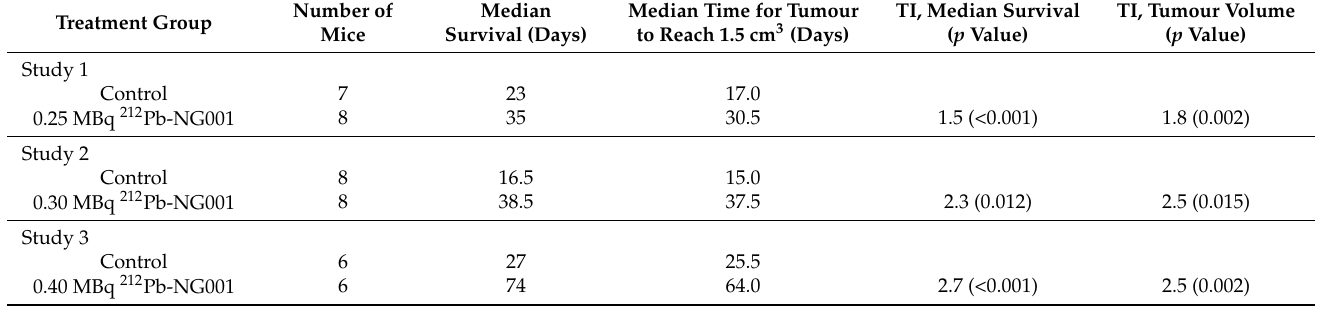
Table 2. The therapeutic effect of 212 Pb-NG001 in athymic nude mice with C4-2 xenografts. The therapeutic index (TI) was calculated from median survival and median time for tumours to reach a volume of 1.5 cm 3 in the treatment groups compared to the control group.